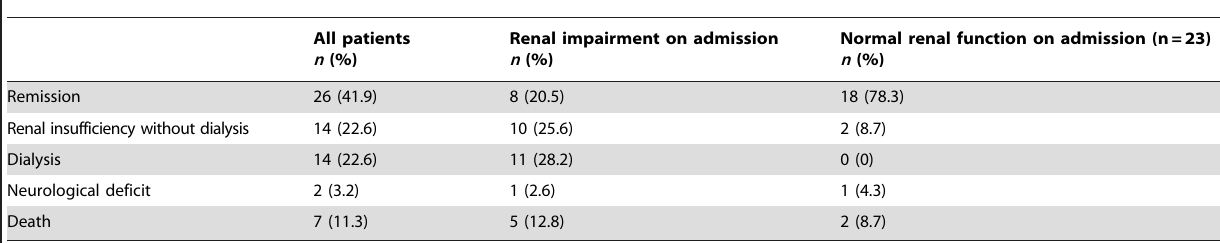
Table 2. Clinical outcome.